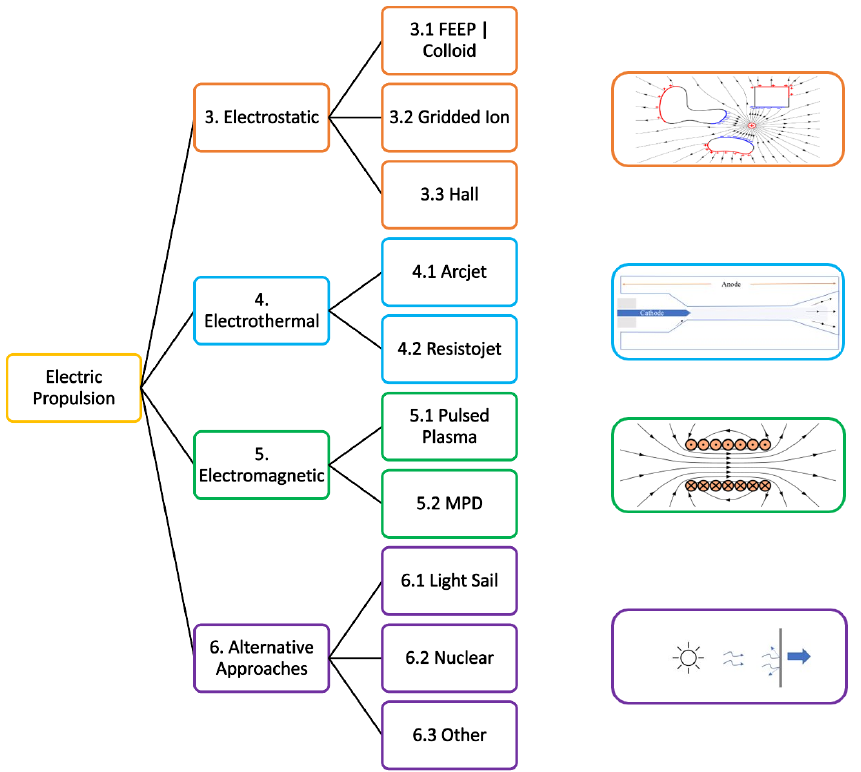
Figure 1. Describes the EP systems which this paper will review. Electric propulsion can be distin- guished by the underlying physics which propels the system whether it be electrostatic, electrothermal or electromagnetic. Alternative approaches describes some additional propulsion systems that are currently under